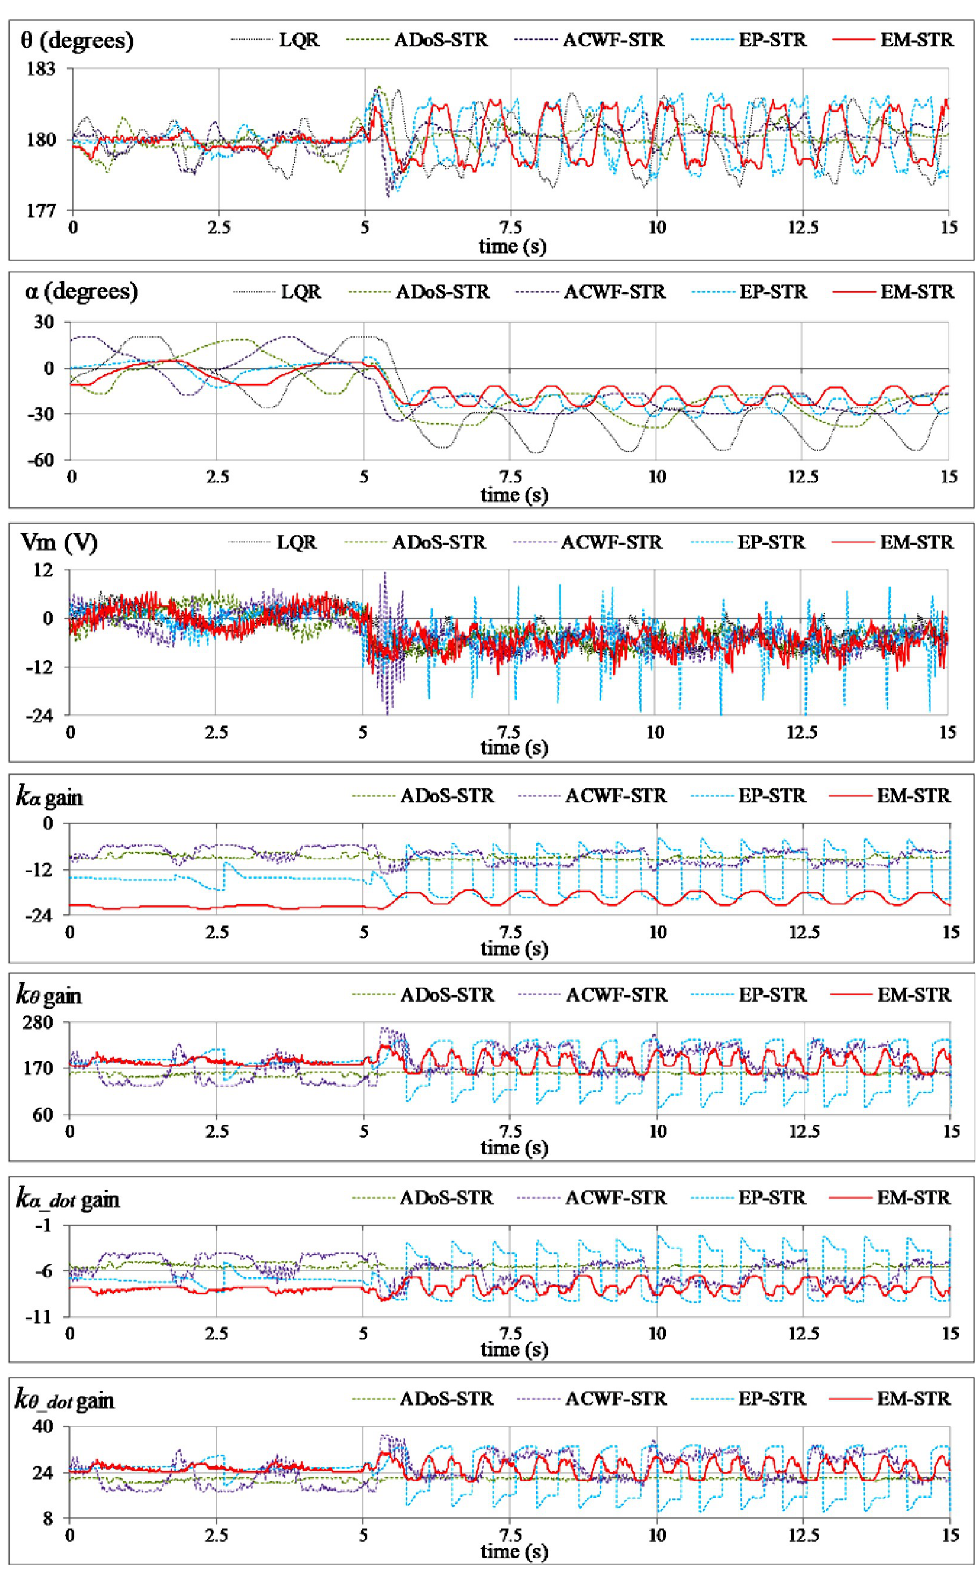
Fig 14. Pendulum’s response under step